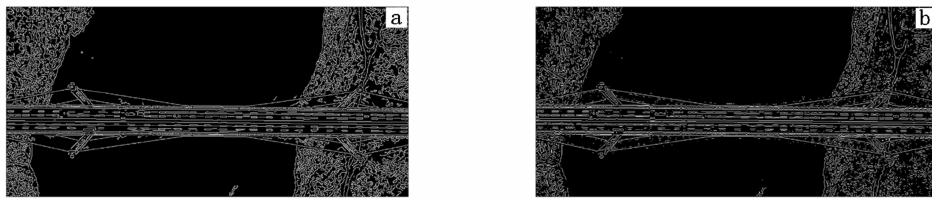
Figure 10. Detection results: ( a ) Canny’s algorithm. ( b ) Laplace’s algorithm.